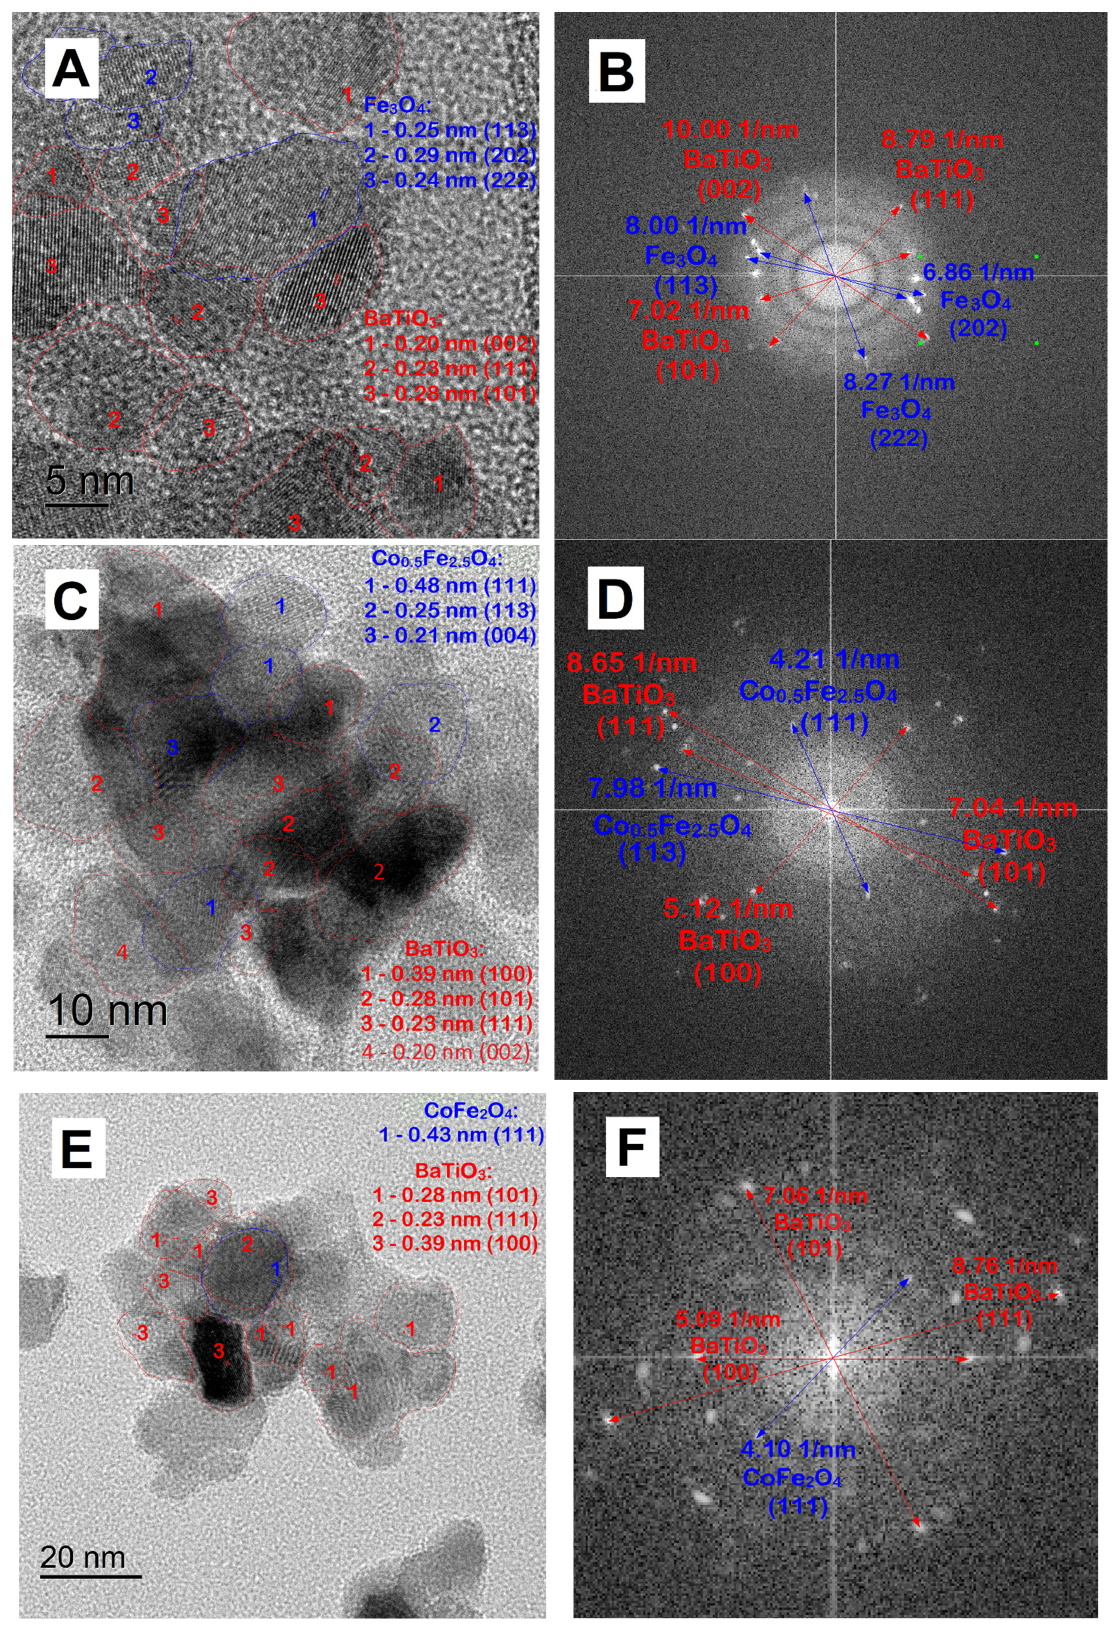
Figure 10. High ‐ resolution TEM images ( A , C , E ) and electron diffraction ( B , D , F ) of x = 0.0 ‐ BT, x = 0.5 ‐ BT, and x = 1.0 ‐ BT after ball milling, respectively.